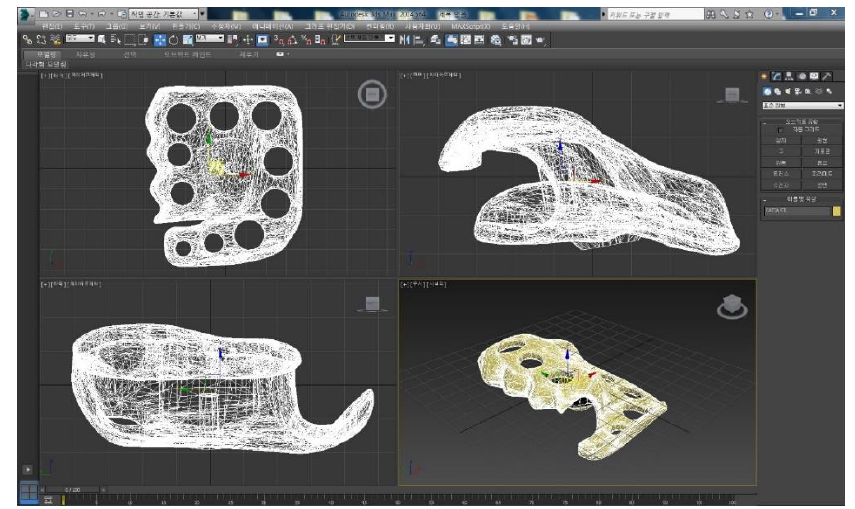
Figure 3. Designing and modelling for 3D printing process of steering controller.